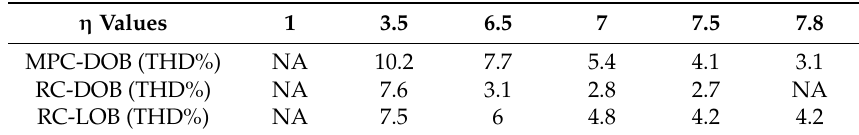
Table 5. THD values for di ff erent η under the nonlinear load ( R nl = 200 Ω , L nl = 10 mH, C nl = 2200 µ F) with the nominal filter parameters.